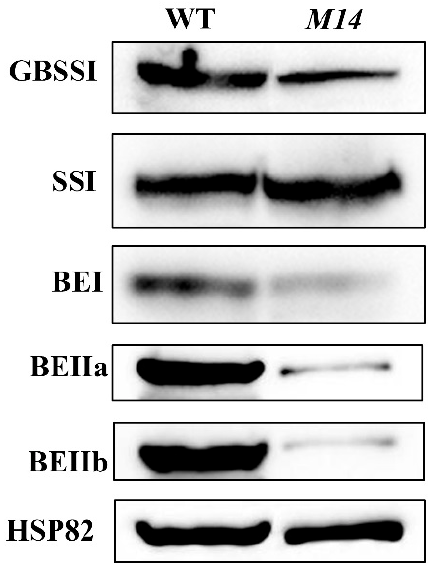
Figure 8. Accumulation of proteins involved in starch synthesis in WT and M14 endosperm at 9 DAF. Anti-GBSSI, anti-SSI, anti-BEI, anti-BEIIa and anti-BEIIb are used for the immunoblot analysis. Anti-HSP82 is used for the loading control.